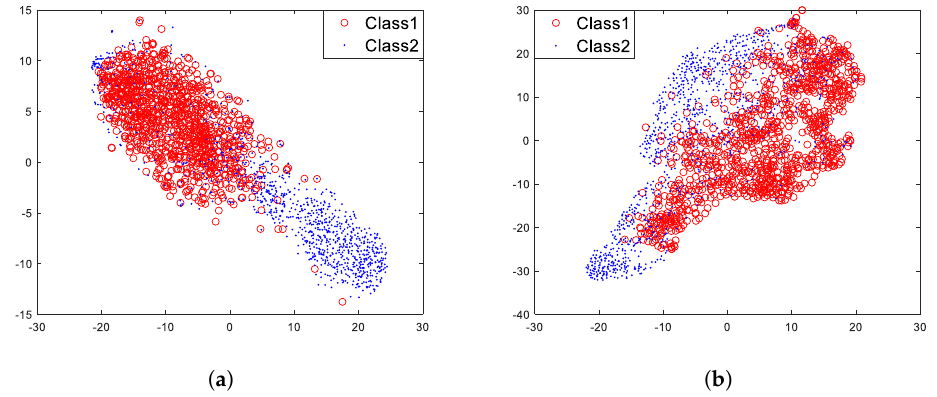
Figure 12. Feature visualization results. ( a ) MFCC features (23 dimensions). ( b ) Feature vectors (32 dimensions) of layer 1 under unsupervised